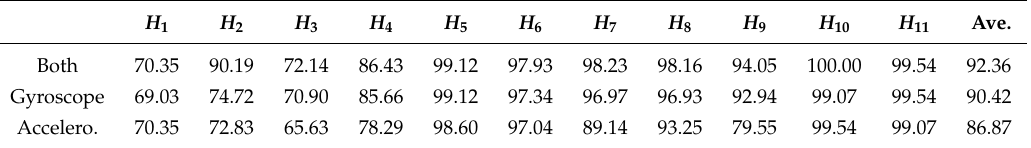
Table 8. The hit rates (in percentage) of the proposed PairNet algorithm with the employment of only accelerometer, gyroscope, or